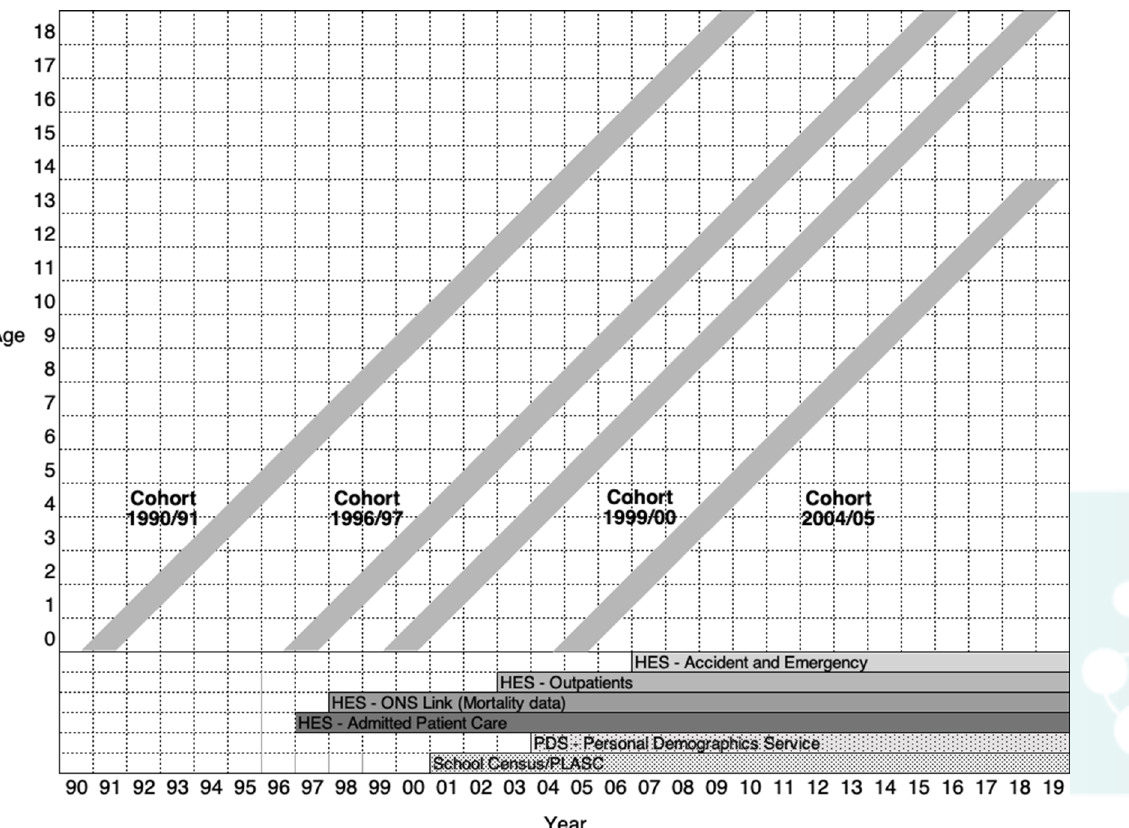
Figure 2: Lexis diagram to show year of age of each cohort (y axis) and start year of each dataset (x